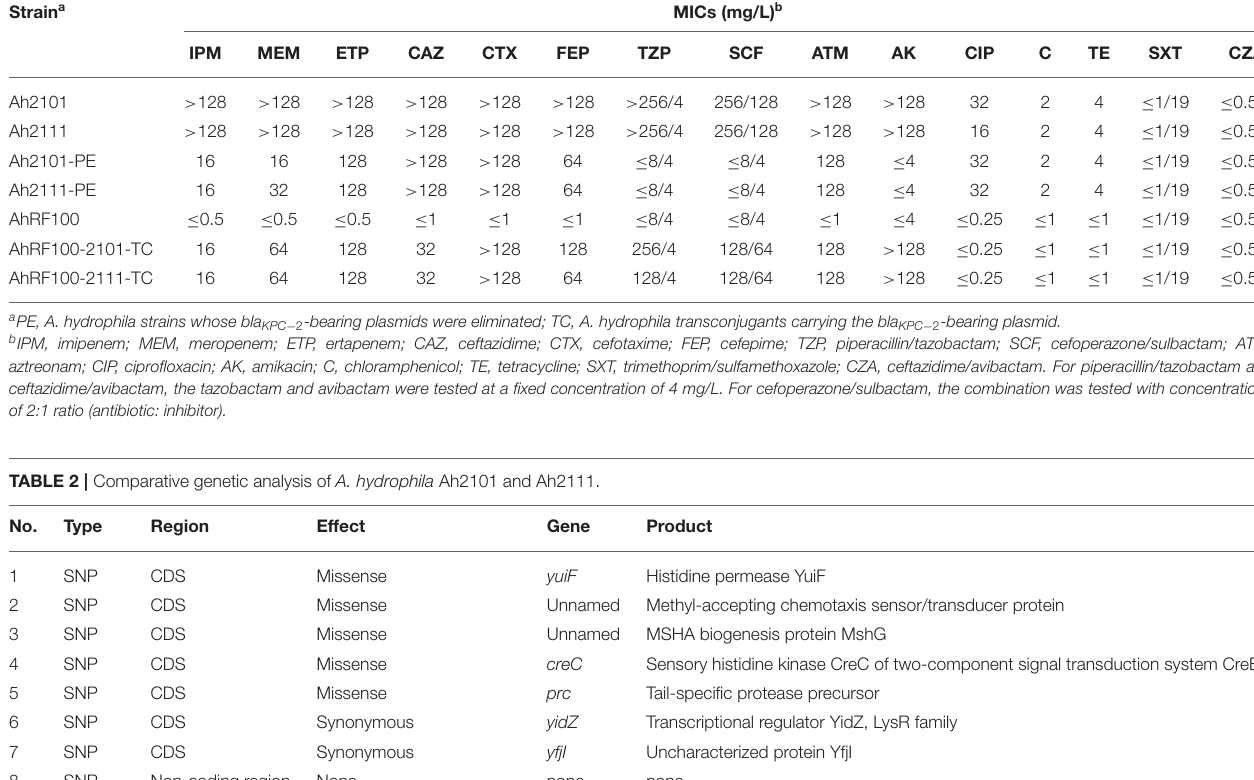
TABLE 1 | Antimicrobial susceptibility of A. hydrophila Ah2101 and Ah2111, the corresponding transconjugants, and plasmid-eliminated strains. Strain a